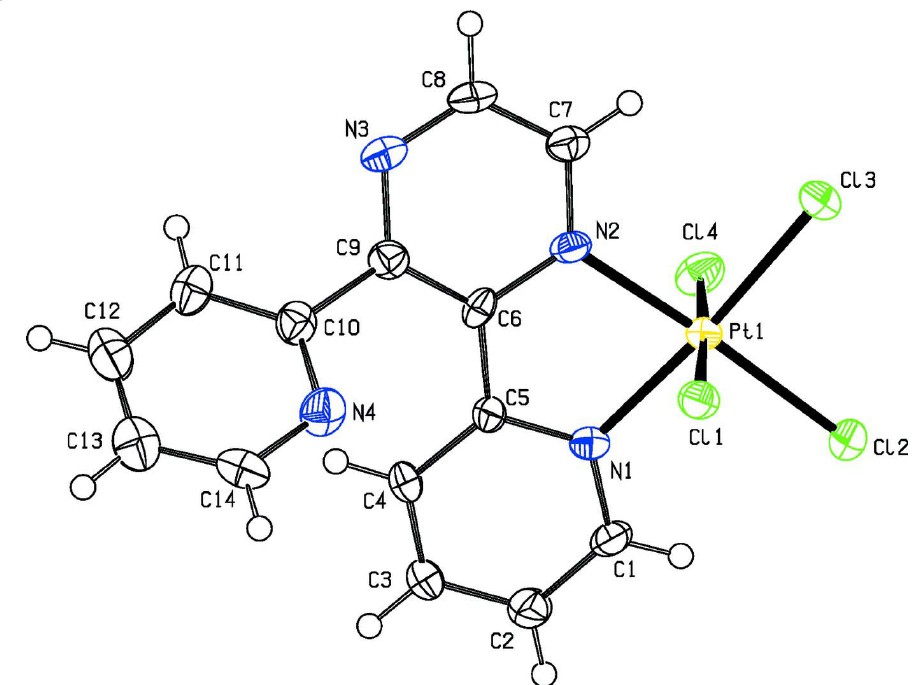
S3. Refinement H atoms were positioned geometrically with C—H = 0.93 Å and constrained to ride on their parent atoms with